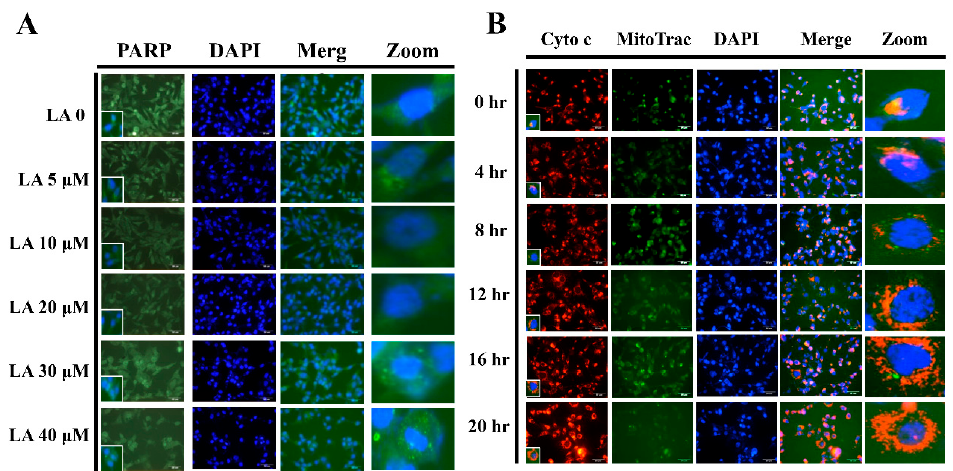
Figure 7. Licochalcone A (LA) regulated PPAR and cytochrome c expression. ( A ) Licochalcone A (LA) induced PPAR translocation from the cytoplasm to nucleus in MDA-MB-231 cells as detected by fluorescence microscopy. The cell nucleus was stained with DAPI solution. ( B ) 40 µ M LA increased cytochrome c translocation from mitochondria to the cytoplasm of MDA-MB-231 cells at the indicated time points (0 to 24 h). The cell nucleus was stained with DAPI solution and mitochondria with Mito Trac solution.